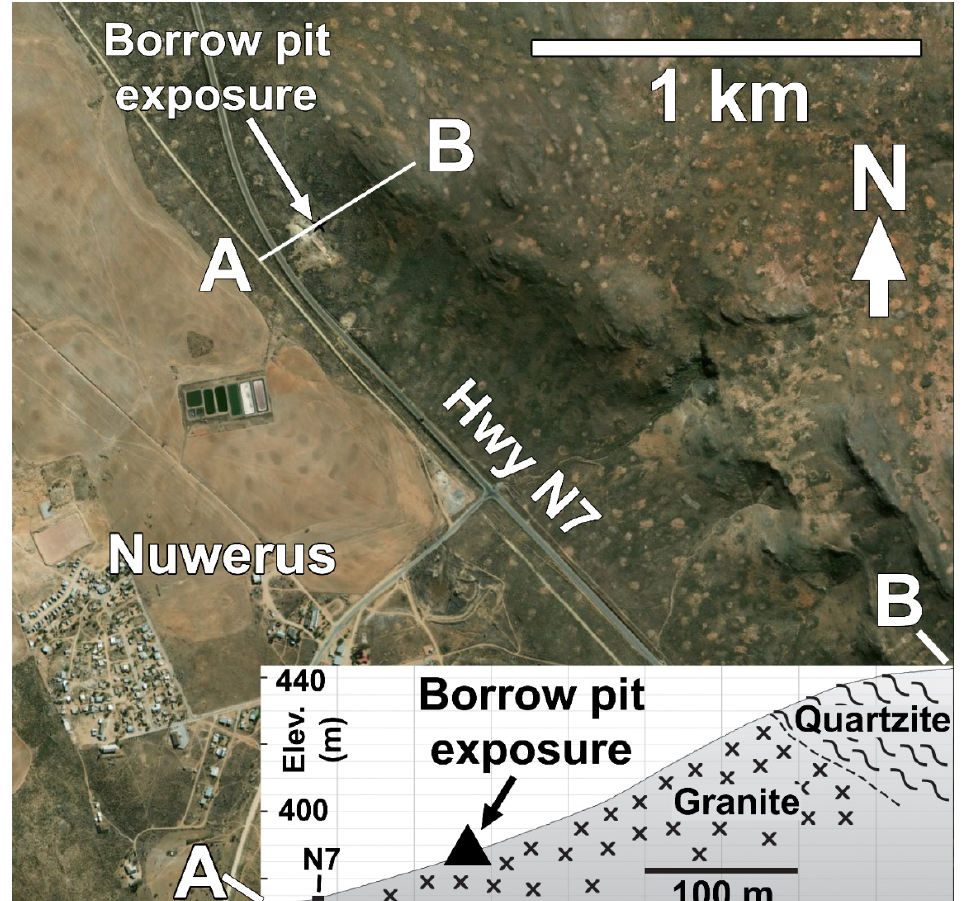
Figure 11. Location of the hillslope study site north of Nuwerus. Coordinates of the borrow pit exposure are −31.13939° S, 18.35702° E. The light-coloured spots on the dark hillslopes are heuweltjies . The inset in the lower right shows the cross-sectional profile A–B; the profile was generated in Google Earth Pro™ along the designated path.